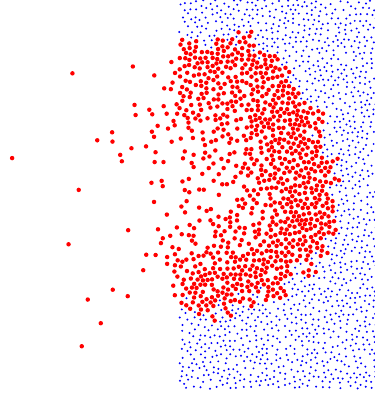
Figure 1: A splash in two dimensions: this shows a snapshot of a gas of hard discs, initially at rest and uniformly distributed on the positive half plane, some time after one disc near the origin is given a velocity in the positive x − direction. Moving par- ticles are shown by red disks; stationary ones are shown by blue disks and their size is shrunk for visual convenience (the figure is adopted from Ref. [ 3 ]